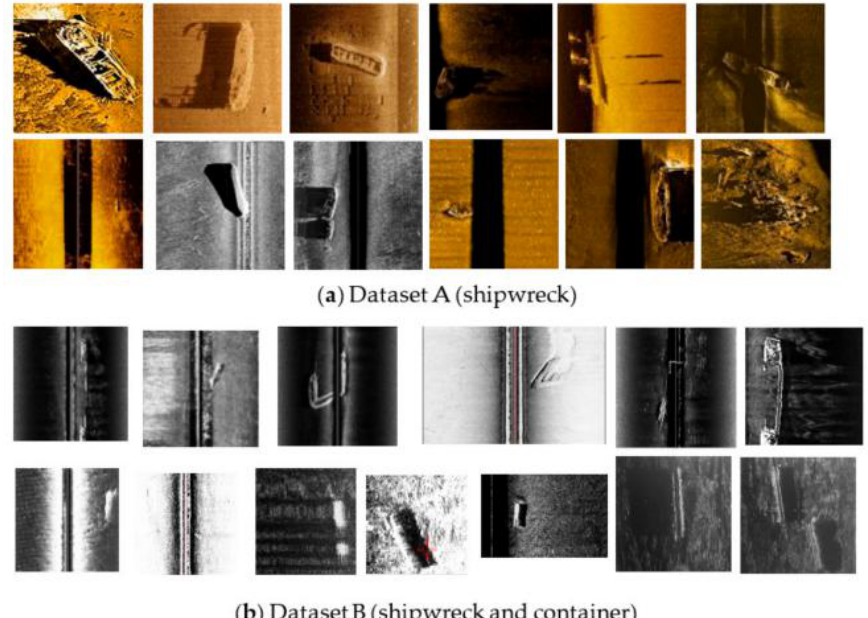
Figure 12. Some samples of data set A and data set B: ( a ) denotes the data set A which only consists of shipwreck targets; ( b ) denotes the data set B. The images in the first row of ( b ) are shipwreck targets and the second row are container